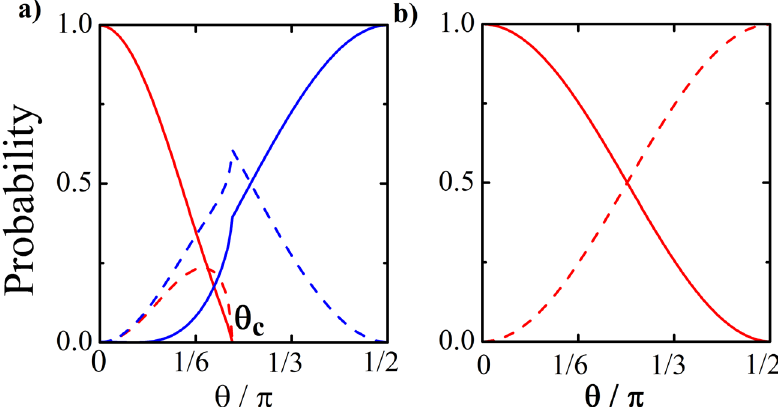
Figure 3. Probability of Andreev and normal reflections vs polar angle of incident. The conventional (spin- flipped) normal reflection is shown by solid (dashed) blue line. Also, the conventional (anomalous) Andreev reflection is prevaricated by solid (dashed)red line. ( a ) For ε = Δ 5 , the Andreev-Klein tunneling occurs in θ = 0. ( b ) In ε = 0, the perfect Andreev reflection occurs for all angles of incidence. The input values are E Δ = 5 m . 5